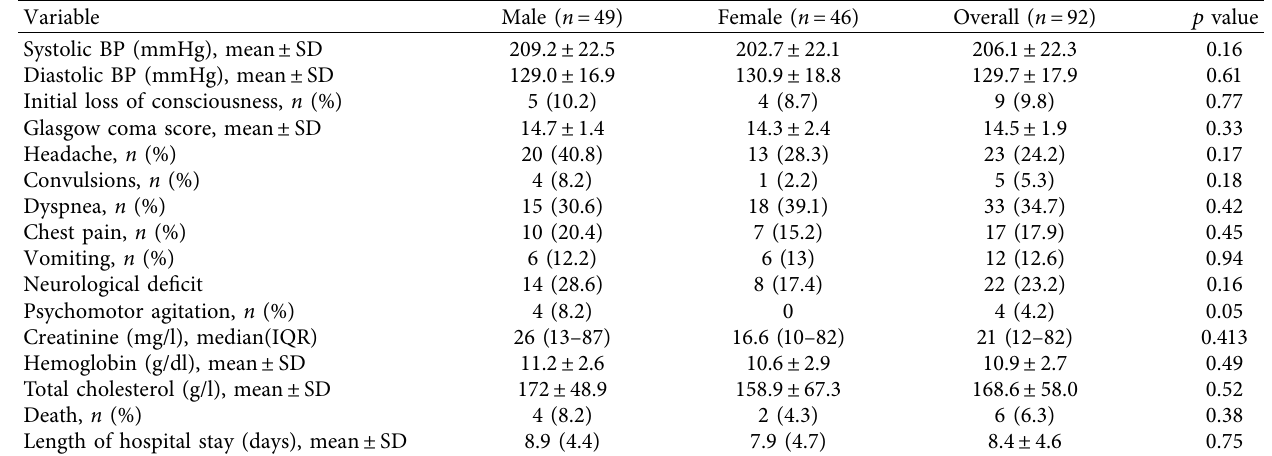
Table 2: Clinical presentation and